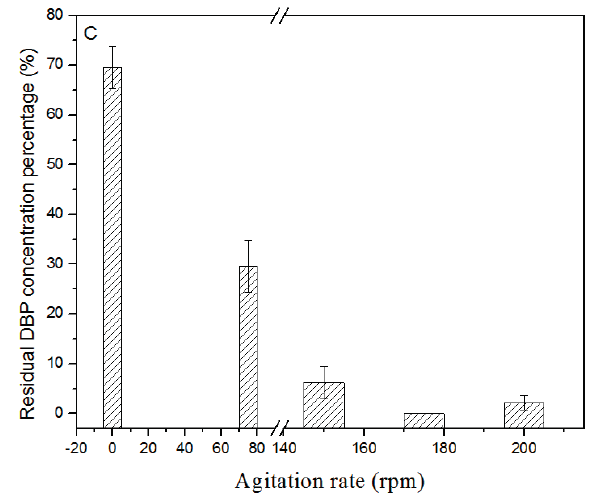
Figure 3. Effect of pH, temperature, and agitation rate on degradation of DBP (500 mg/L) by strain W-1. A: pH; B: temperature; C: agitation rate; Error bars are the standard error of